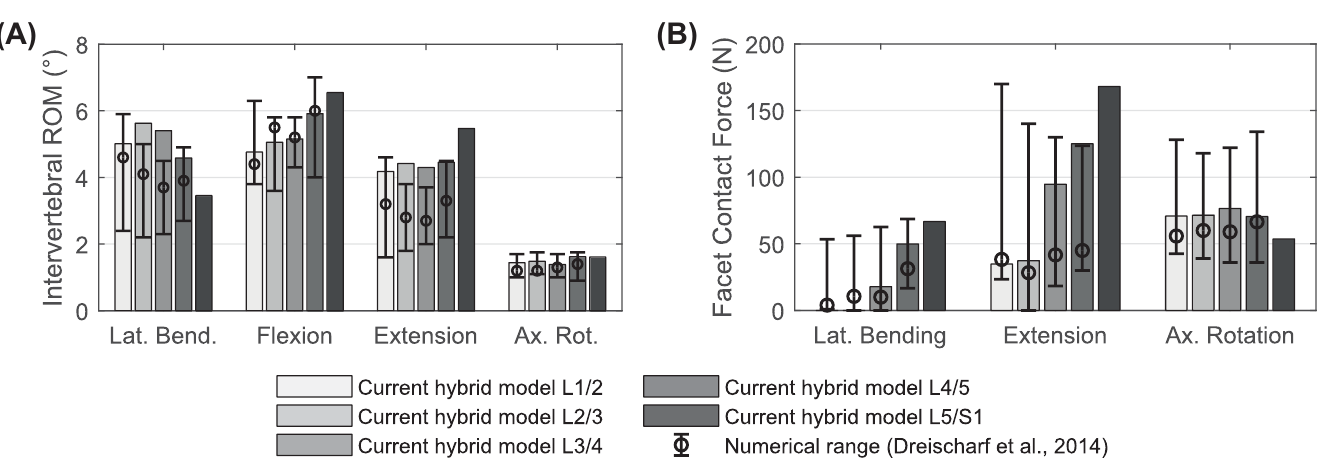
Fig 10. Mechanical responses of the hybrid LSS under combined loading modes (Table 3). (A) Predicted intervertebral ROM and (B) facet contact forces are compared to the median values and value ranges (error bars) of six published numerical lumbar spine models [97]. https://doi.org/10.1371/journal.pone.0250456.g010 stiffnesses are: 718 N/mm for L4/5, 790 N/mm for L2/3, 798 N/mm for L3/4, 950 N/mm for L5/S1, and 1063 N/mm for L1/2. Axial displacements measured in vitro with a 1.2 kN FL [15] are in very good agreement with our results. The largest axial displacement was also found in vitro at levels L2/3, L3/4, and L4/5 with an average of 1.5 ± 0.55 mm (800 ± 293 N/mm). In the same study the levels L1/2 and L5/S1 showed the highest stiffnesses with an average of 960 ± 370 N/mm (1.25 ± 0.4 mm). Another in vitro study measured individually axial displacements for all lumbosacral planes under 250 N compression but showed great variance (0.61 ± 0.29